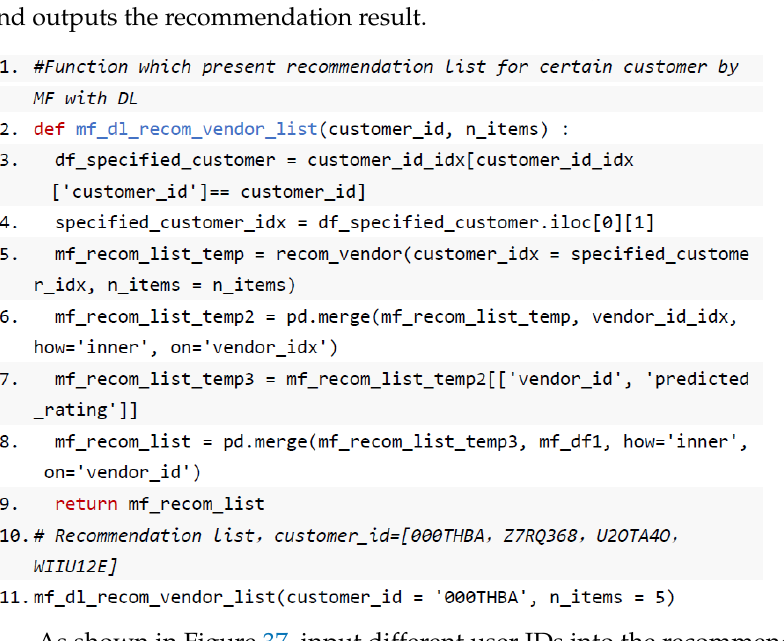
Figure 36. Performance evaluation of recommendation system based on RMSE and LOSS.